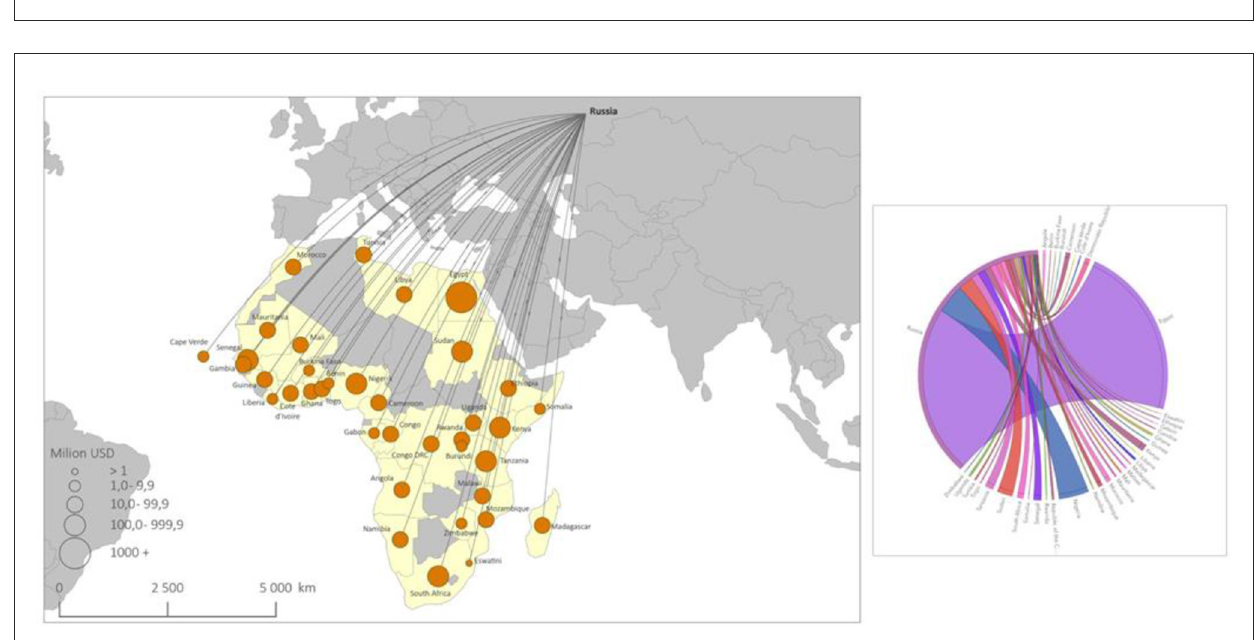
FIGURE3 Top wheat exporters to Egypt, 2020. Source: Authors based on OEC data, 2022.